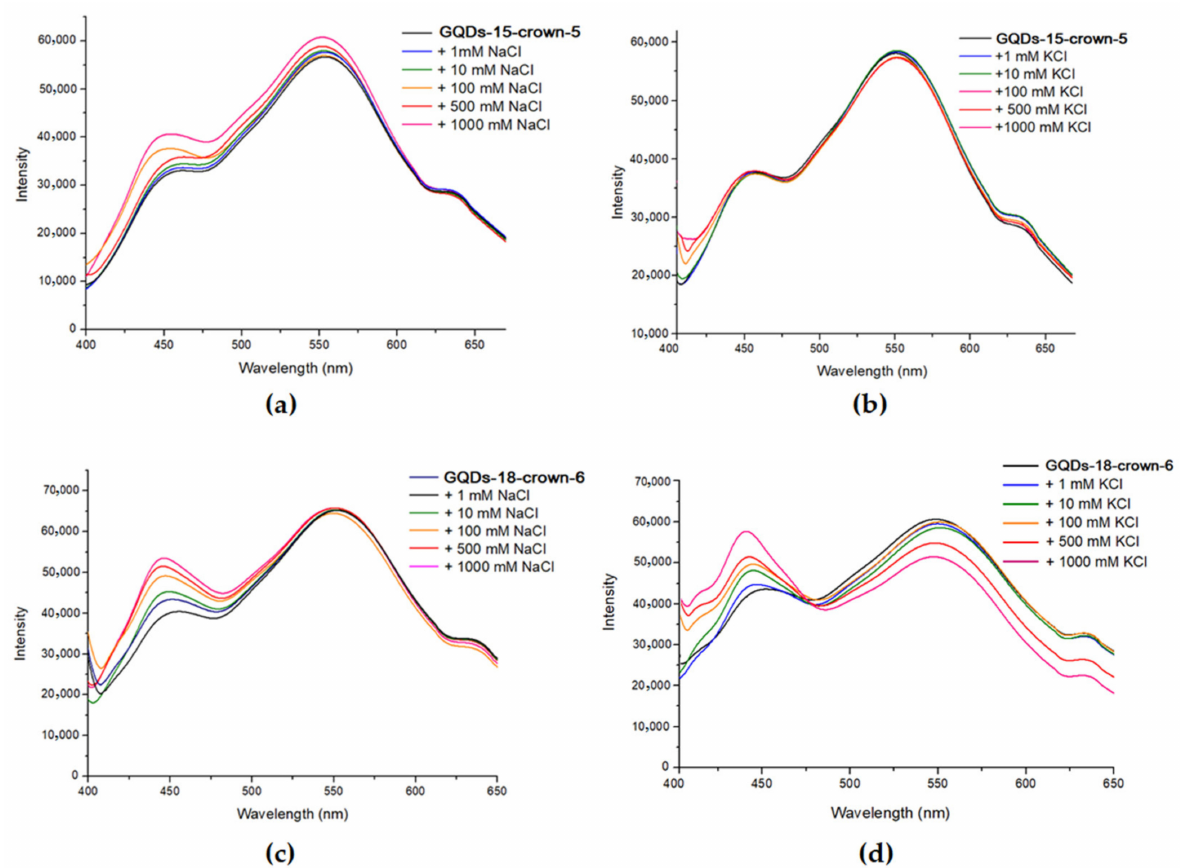
Figure 6. PL spectra of GQDs-15-crown-5 in the presence of different concentrations of ( a ) NaCl or ( b ) KCl and PL spectra of GQDs-18-crown-6 in the presence of different concentrations of ( c ) NaCl and ( d ) KCl. All spectra were performed at the λ exc of 360 nm at the concentration of 100